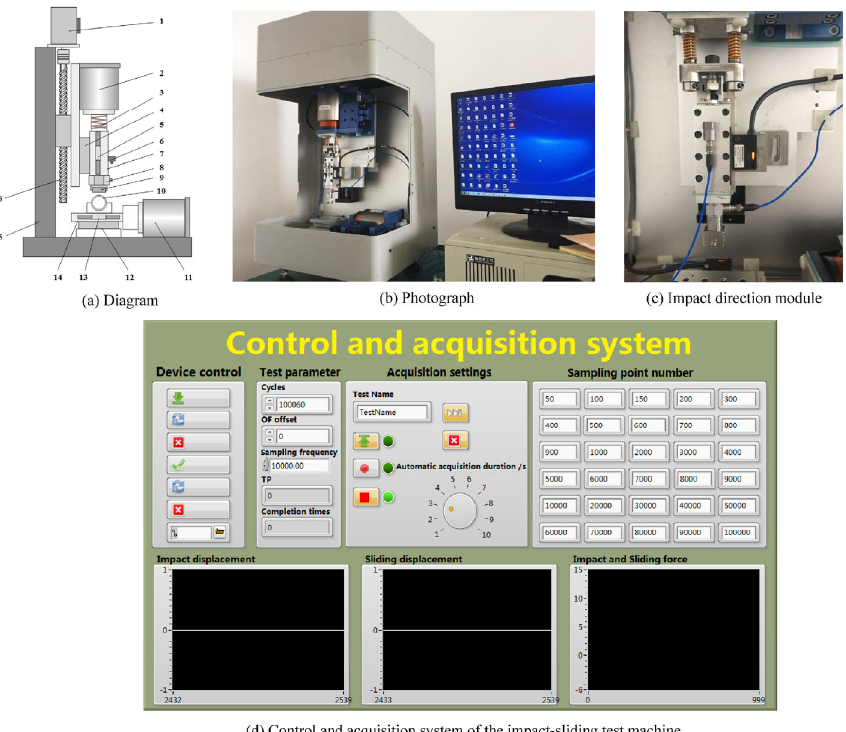
Fig. 2 Impact-sliding wear test rig (1—servo motor, 2— z -voice coil motor, 3—spring damper, 4— z -linear slider, 5— z -magnetic grating transducer, 6—acceleration transducer, 7—joint plate, 8—two-dimensional force sensor ( F X , F Z ), 9—upper specimen, 10—lower specimen, 11— x -voice coil motor, 12— x -linear slider, 13— x -magnetic grating transducer, 14—platform, 15—frame, 16—lead